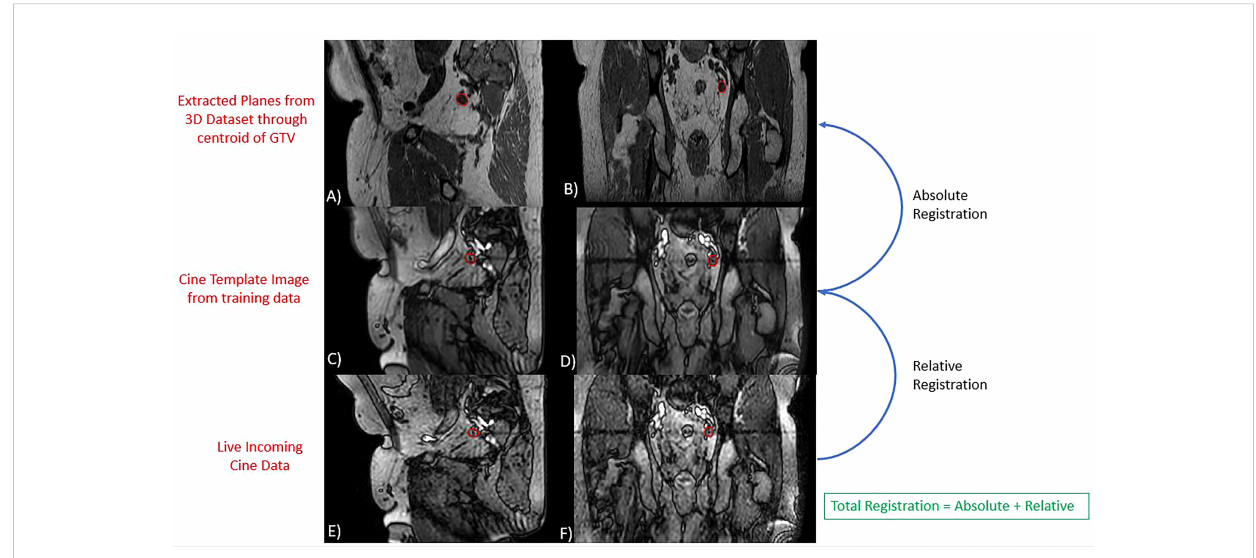
FIGURE 1 Overview of Tracking Algorithm. Images (A, B) represent extracted planes taken through the centroid of the GTV on the daily 3D MRI dataset. Images (C, D) are the sagittal and coronal template images generated from the algorithms training phase. Images (E, F) are live incoming sagittal and coronal cine motion monitoring images. In each image, the red contour represents the GTV structure contoured during planning (A, B) or identi fi ed by the tracking algorithm (C – F) . The algorithms reported target position is equal to the sum of the relative and absolute registration